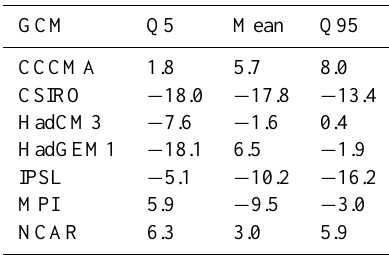
Table 3. Percent change in Pakse (Mekong 2) annual mean, Q5 and Q95 discharges for 2 ◦ C increase in global mean temperature using seven GCMs.